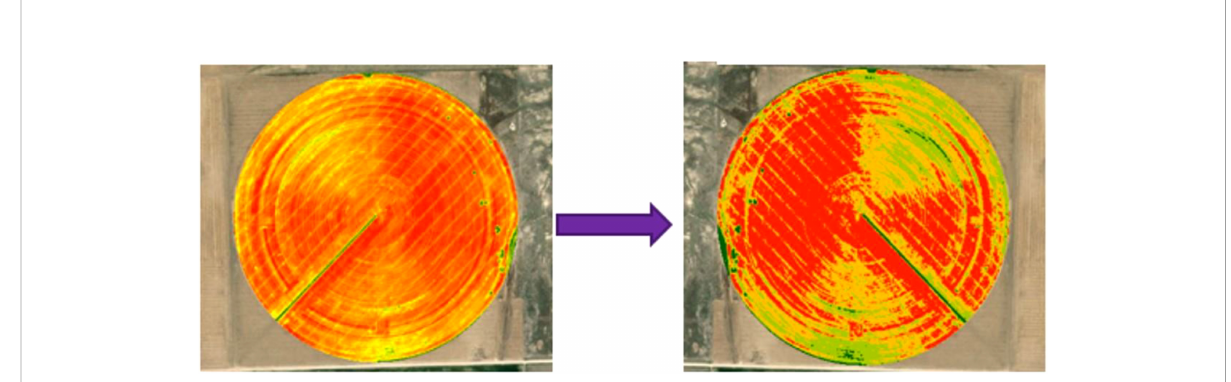
FIGURE 10 Weekly ET maps (left) are aggregated using k-means clustering to mimic variable fl ow control zones